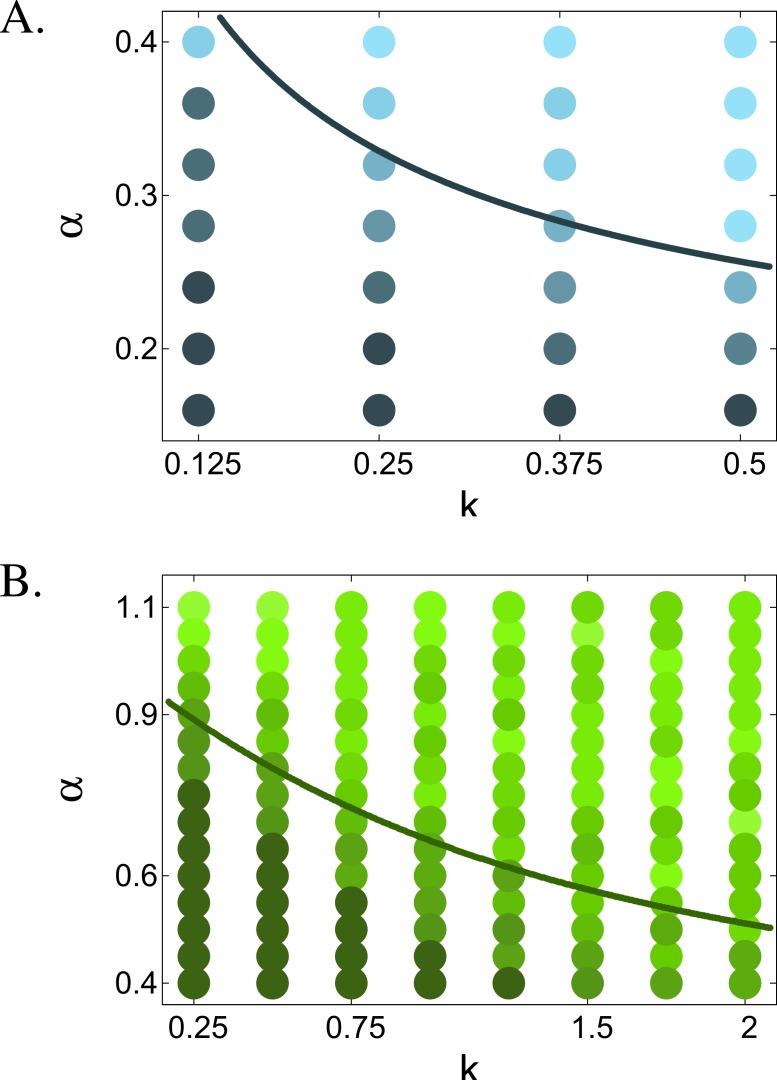
Frequency of branching at different k and α values in model (I) (A) and (II) (B).The solid curves are the predicted border lines, above which branching never occurs in the related analytical models. The darkness of the points denotes the number of branching events out of 20 at a given parameter combination with the darkest colour denoting 20 and the lightest denoting 0 branching events.